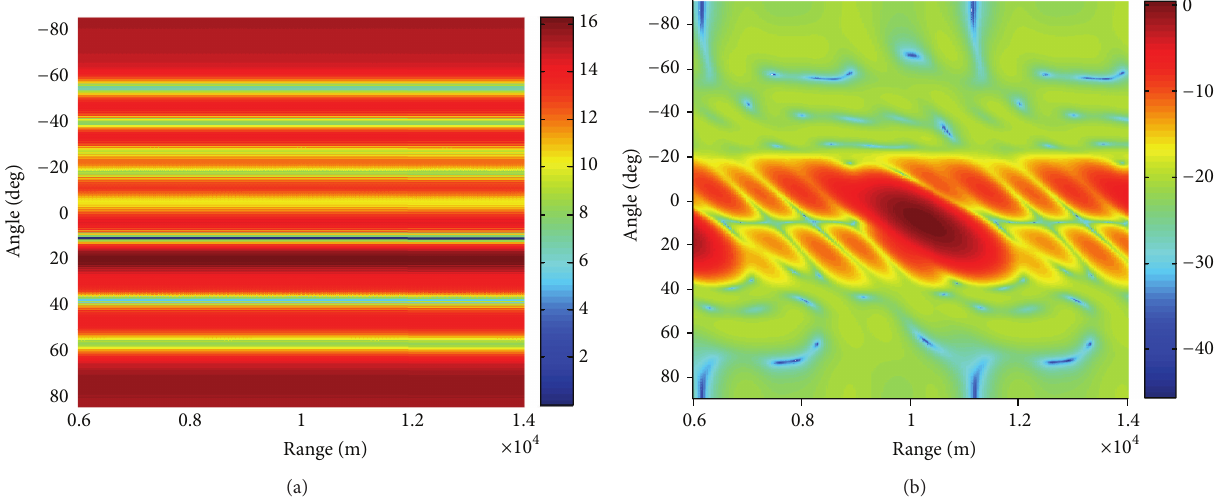
Figure 1: Comparative transmit beampattern: (a) conventional MIMO radar and (b) FDA MIMO radar.